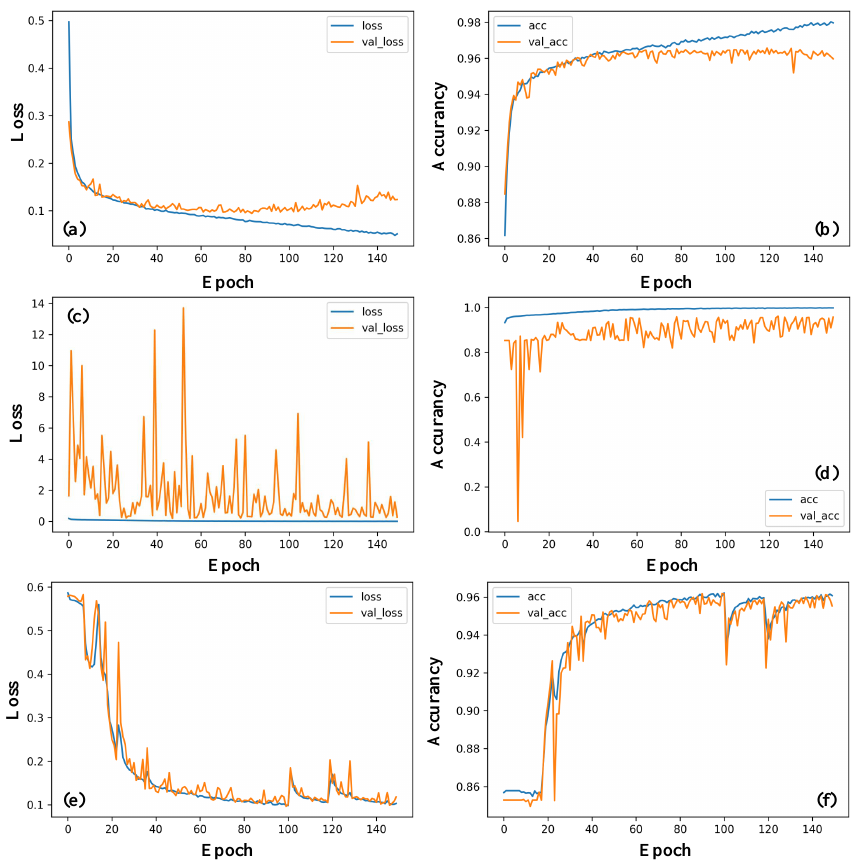
Figure 8. Training loss and accuracy curves of ( a , b ) 1D-CSNN, ( c , d ) 1D-CNN, and ( e , f ) LSTM using frequency-domain signal